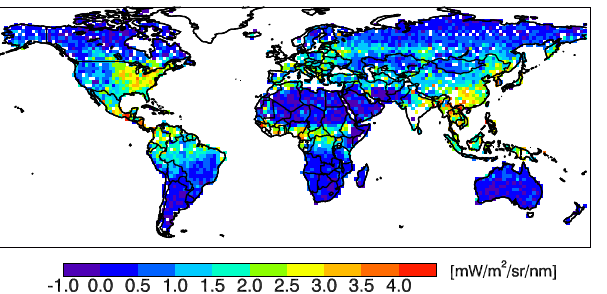
Fig. 7. Derived monthly averages for instantaneous fluorescence F (mWm − 2 sr − 1 nm − 1 ) for July 2009 from GOSAT P polarization. Fig. 8. 8-day FPAR product (unitless) from MODIS for 20–27July 2009.